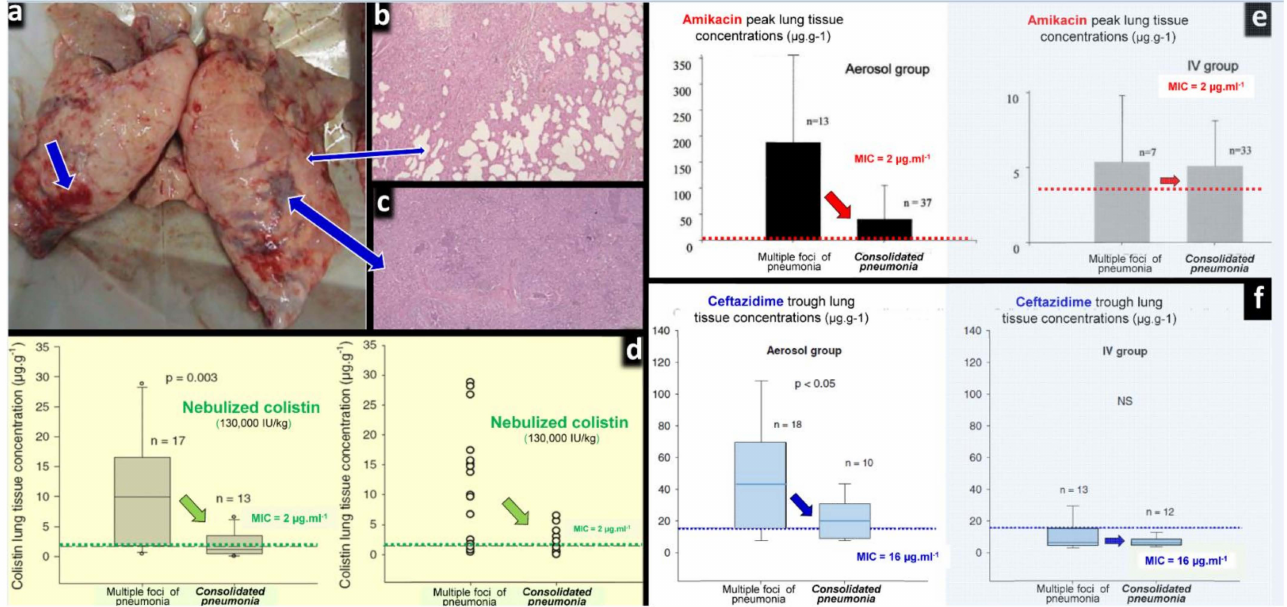
Figure 9. Effects of lung aeration loss on the lung tissue concentrations after the nebulization of high doses of colistin, amikacin and ceftazidime to anesthetized and ventilated piglets with inoculation pneumonia. ( a ) Post-mortem macroscopic view of a piglet’s lungs after intra-bronchial inoculation of Pseudomonas aeruginosa . Thick blue arrows indicate lung areas of consolidation and thin blue arrows indicate areas of foci of bronchopneumonia. ( b ) Histologic sections corresponding to foci of bronchopneumonia with persisting lung aeration. ( c ) Histologic sections corresponding to areas of consolidation with complete loss of lung aeration. ( d ) Colistin peak lung tissue concentrations measured by high-performance liquid chromatography 24 h after the intra-bronchial inoculation of Pseudomonas aeruginosa (MIC = 2 µ g · mL − 1 ) and the nebulization of 130,000 international units · kg − 1 of colistimethate sodium ( n = 6). Following the intravenous administration of high doses of colistimethate sodium ( n = 6), colistin lung tissue concentrations were undetected. ( e ) Amikacin peak lung tissue concentrations measured by high-performance liquid chromatography 24 h after the intra-bronchial inoculation of Escherichia coli (MIC = 4 µ g · mL − 1 ), either by nebulization (45 mg · kg − 1 · day − 1 , n = 10) or by intravenous infusion (15 mg · kg − 1 · day − 1 , n = 8) [99]. ( f ) Ceftazidime trough lung tissue concentrations measured by high-performance liquid chromatography 24 h after the intra-bronchial inoculation of Pseudomonas aeruginosa (MIC = 16 µ g · mL − 1 ), and the nebulization of 25 mg · kg − 1 at 3 h intervals ( n = 6) or the continuous intravenous infusion of 90 mg · kg − 1 · day − 1 after an initial rapid infusion of 30 mg · kg − 1 ( n = 6). (Figure 9a–c,f)